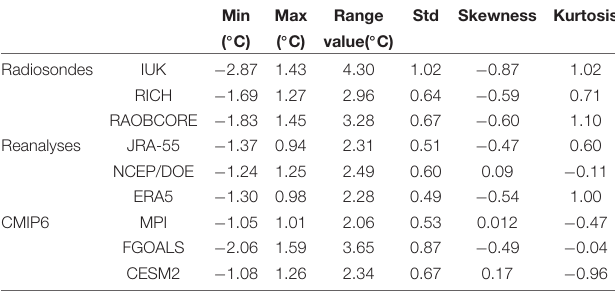
TABLE 2 | The statistics of the summer thermal contrasts (TTI) for the different data. Min Max